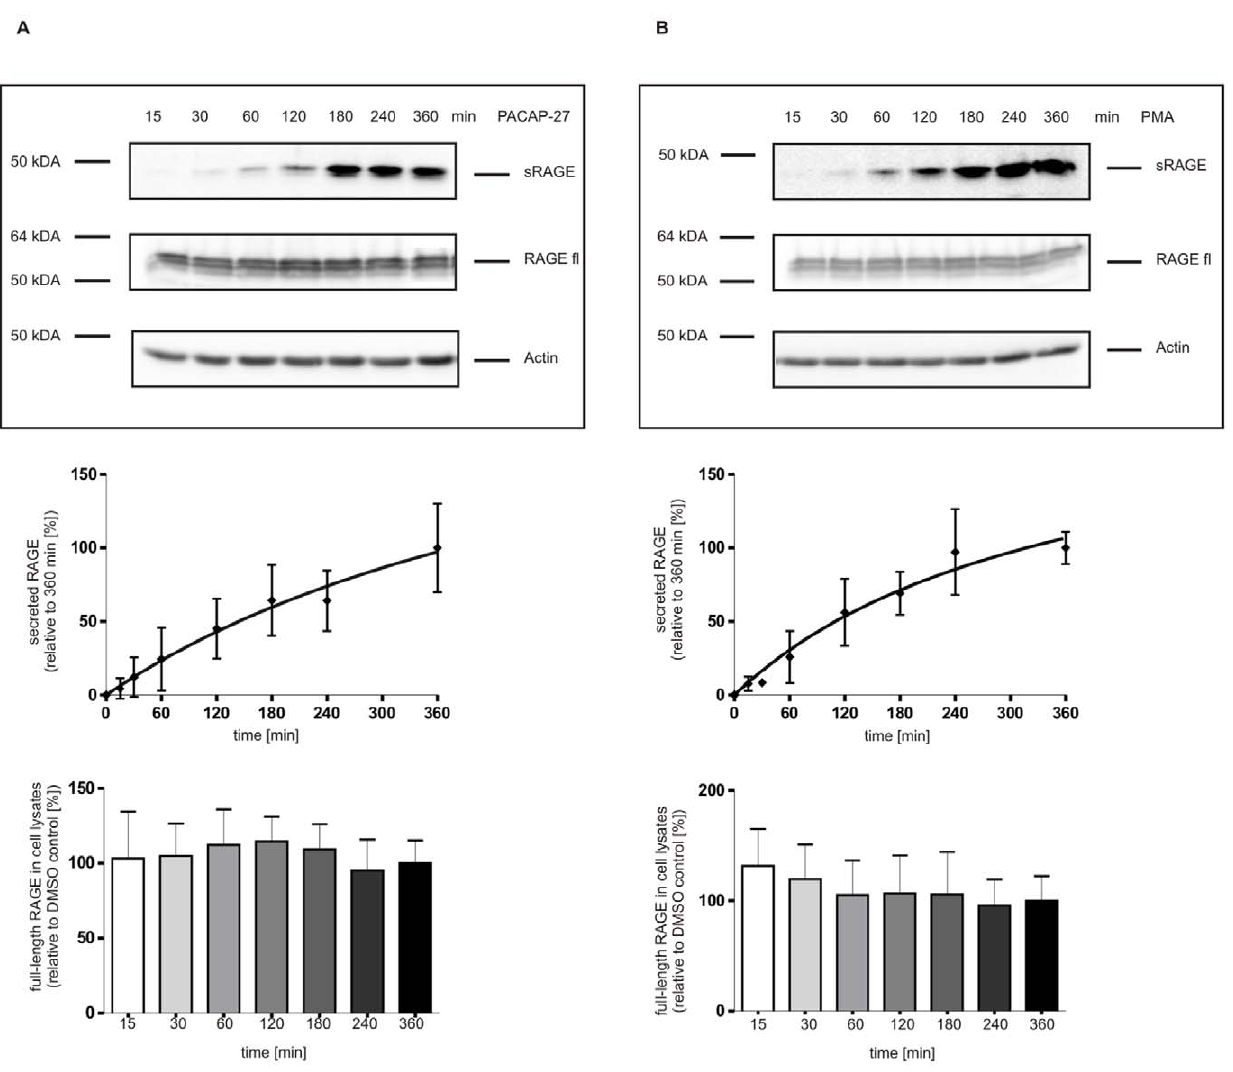
Figure 5. Time dependence of RAGE shedding induced by either PACAP (A) or PMA (B). Upper figure part: representative Western blots for detection of sRAGE, full-length RAGE (RAGE fl) and actin; middle figure part: Quantitative analysis of sRAGE amounts; lower figure part: Quantification of full-length RAGE expression. PAC1/RAGE cells were incubated for different periods of time (15 min up to 360 min) using either 300 nM PACAP-27 or 1 m M PMA. sRAGE was detected and quantified as described in Figure 1. Full-length RAGE and actin were analyzed in cell lysates by Western blotting using either the monoclonal anti-RAGE antibody 5328 or anti-actin antibody A2066. Detection was performed with ECL. For quantification of sRAGE and full-length RAGE, the experiments were done in triplicates. Shown are the mean effects 6 S.D.